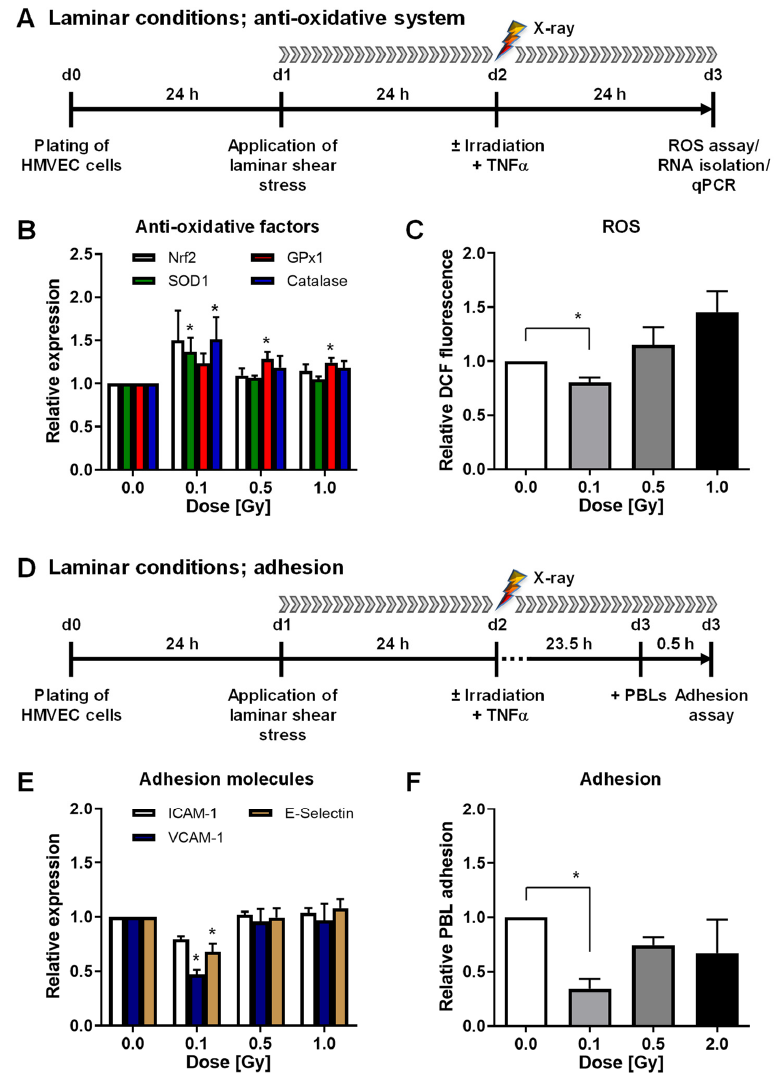
Figure 1. Low-dose X-irradiation modulates mRNA expression of anti-oxidative factors, reduces reactive oxygen species (ROS) and peripheral blood lymphocyte (PBL) adhesion to human microvascular endothelial cells (HMVEC) under laminar conditions. ( A ) Experimental setup: For analysis of the mRNA expression of anti-oxidative factors, ROS and adhesion molecules under shear stress, laminar flow conditions were applied 24 h after plating of HMVEC. ( B ) After irradiation and stimulation with tumor necrosis factor alpha (TNF- α ), RNA was isolated to measure the mRNA expression of anti-oxidative factors (Nrf2, Nuclear factor-erythroid-2-related factor 2; SOD1, Superoxide Dis- mutase 1; GPx1, Glutathione Peroxidase 1; Catalase) by quantitative PCR (qPCR) (mean + SEM; n = 6) or ( C ) cells were subjected to analysis of ROS by flow cytometry (mean + SEM; n = 8–12). ( D ) For adhesion assays, PBL were added 23.5 h after irradiation and adhesion was allowed for 0.5 h under constant laminar flow. ( E ) Measurement of adhesion molecules vascular cellular adhesion molecule (VCAM)-1, intercellular adhesion molecule (ICAM)-1, and E-selectin expression was per- formed by qPCR (mean + SEM; n = 6). ( F ) For adhesion assays, HMVEC were plated on glass cover slips, PBL were stained with CellTracker Green CMFDA (5-chloromethylfluorescein diacetate) and added 23.5 h after irradiation for 30 min to the medium reservoir under permanent laminar flow. HMVEC cells and adhered PBL were fixed and stained with 4 (cid:48) ,6-diamidino-2-dhenylindol (DAPI) and phalloidin-tetramethylrhodamine B isothiocyanate (phalloidin-TRITC). PBL adhesion was evaluated by microscopic counting of PBL relative to the number of endothelial cells (mean + SEM; n = 5–9). * p < 0.05, Kruskal-Wallis test vs. 0